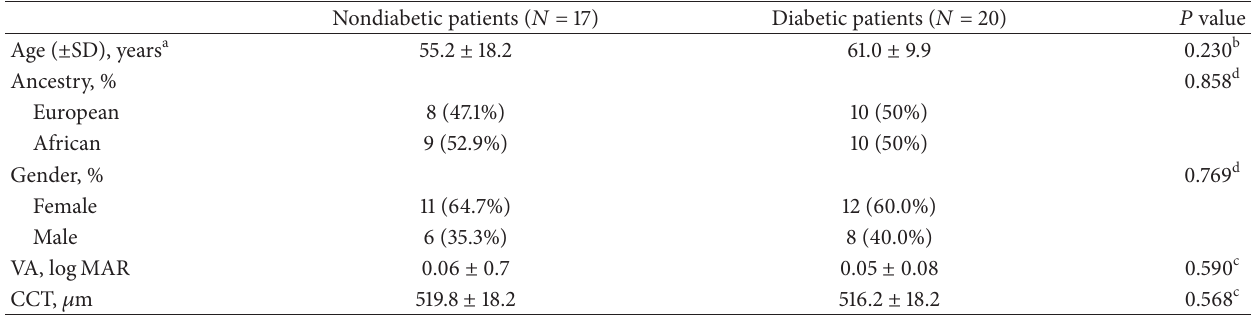
Table 1: Demographic and clinical variables in eyes of nondiabetics and diabetics group.